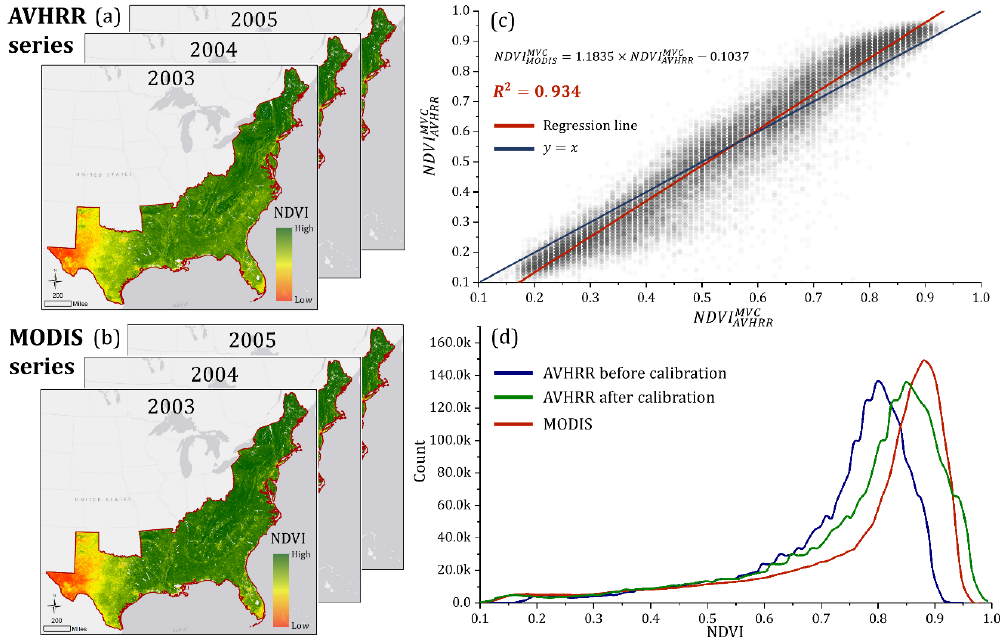
Figure 4. (a) NDVI MVC series from AVHRR in the overlaying years; (b) NDVI MVC series from MODIS in the overlaying years; (c) linear regression between AVHRR and MODIS using stratified sampling; (d) comparison of histograms between MODIS and AVHRR (before and after calibration). Basemap sources: Esri, HERE, Garmin, OpenStreetMap contributors, and the GIS user community. © OpenStreetMap contributors 2019. Distributed under a Creative Commons BY-SA